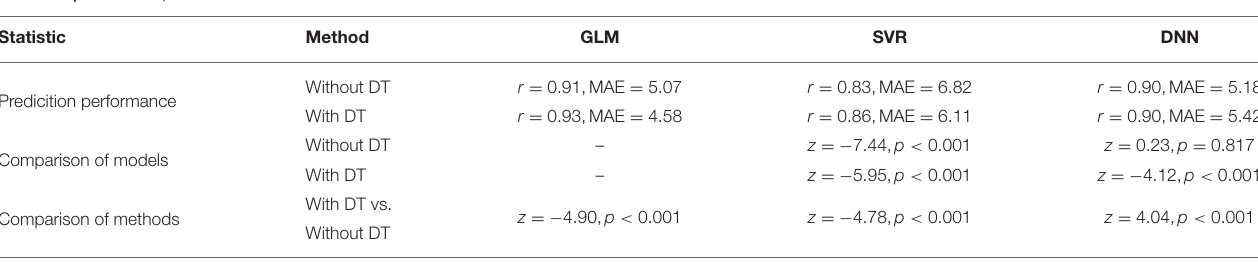
TABLE 4 | Prediction performance across models and